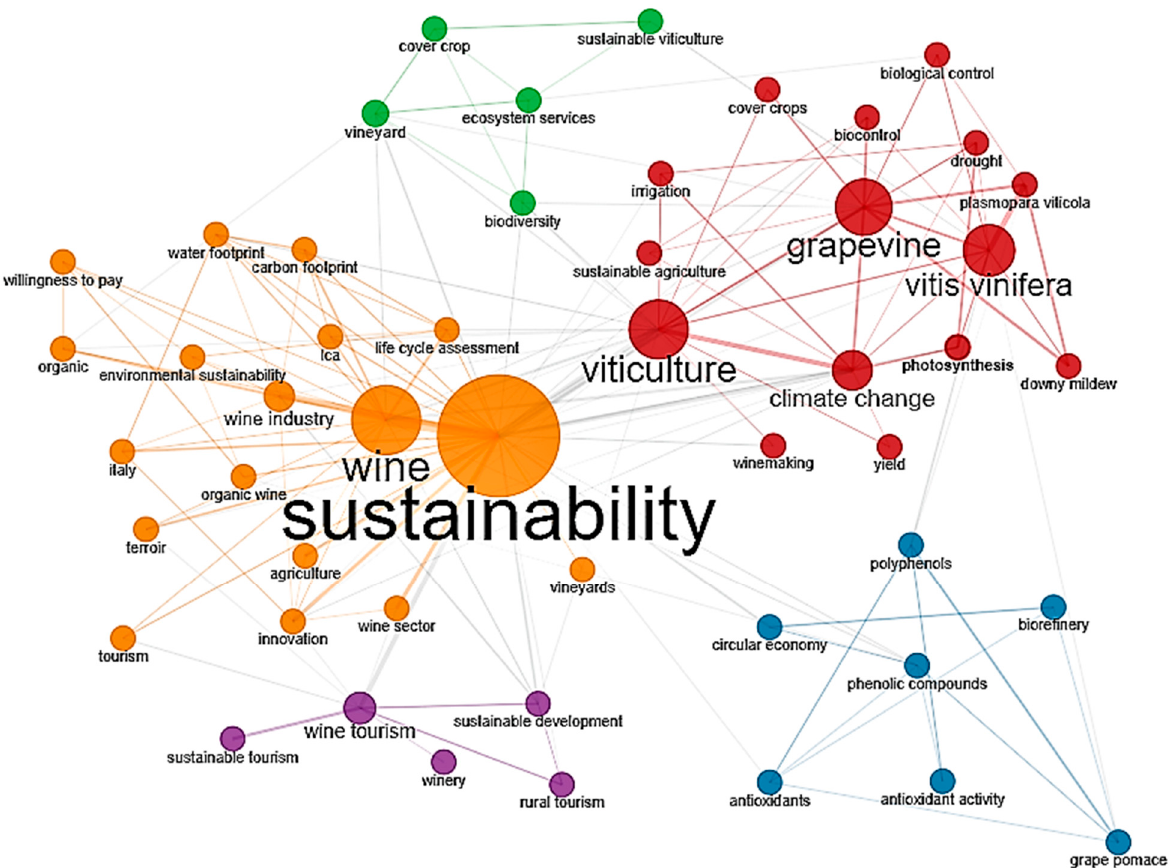
Figure 6. Co-occurrence network of keywords .